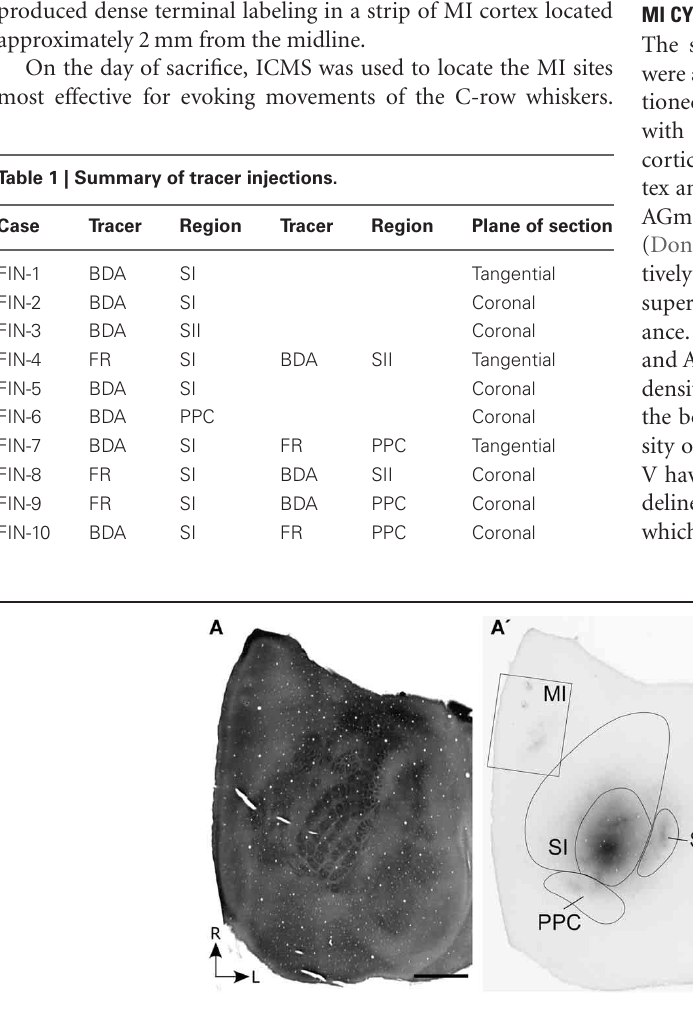
somatosensory cortical areas as well as the posterior parietal cortex (PPC). Rectangle indicates the region depicted in panel (B) . (B) Location of two electrolytic lesions (red arrows) marking where intracranial microstimulation (ICMS) was most effective in evoking whisker twitches. Labeled projections (arrowheads) from SI terminate in a strip of MI cortex located caudal and lateral to sites that evoked the best whisker responses. Scale bars: 2mm in (A) ; 500 μ m in (B)